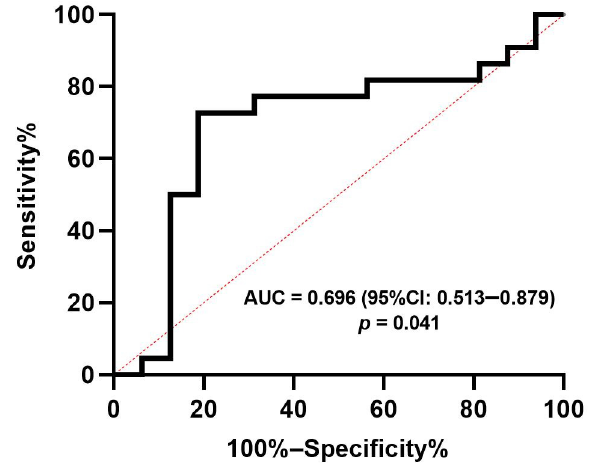
Figure 4. Predictive value of Galectin-3 levels on day 1 (at admission) for 30-day all-cause mortality in patients with CS complicating AMI. The under-area ROC curve was 0.696 (95% CI: 0.513–0.879). The optimal cut-off point was less than 3651 pg/mL, with sensitivity and specificity of 72.7% and 81.3%, respectively. The red dotted line indicates the diagonal line of the ROC curve. CS, cardiogenic shock. AMI, acute myocardial infraction.